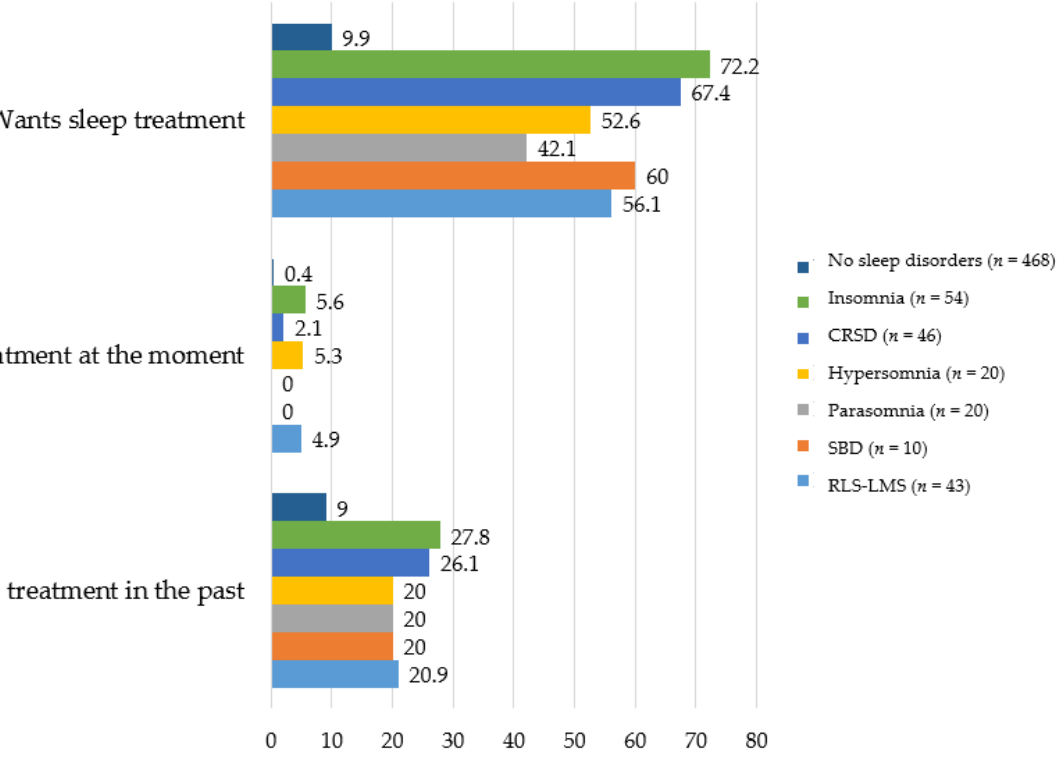
Figure 1. Treatment needs and use per sleep disorder in percentages.